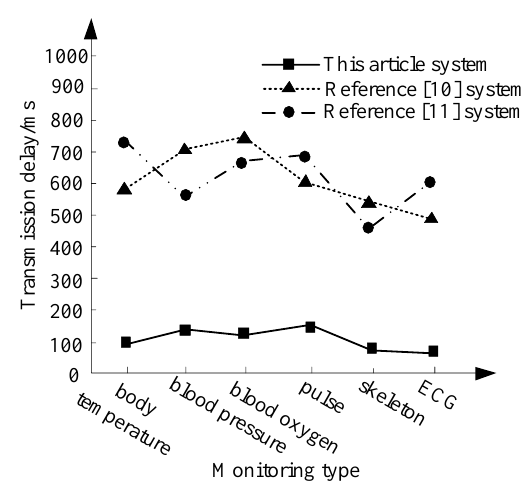
Figure 8. System operation transmission